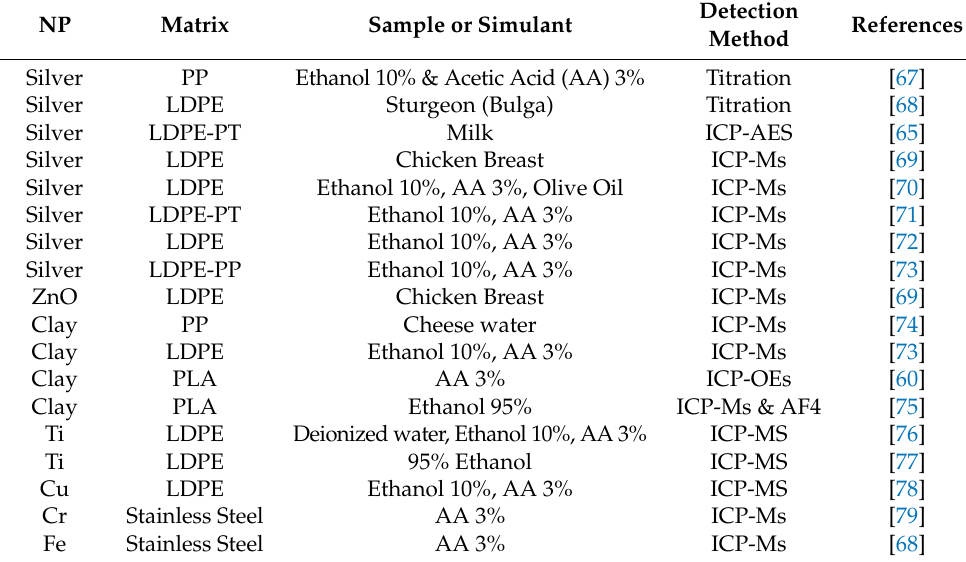
Table 1. A summary of migration studies on